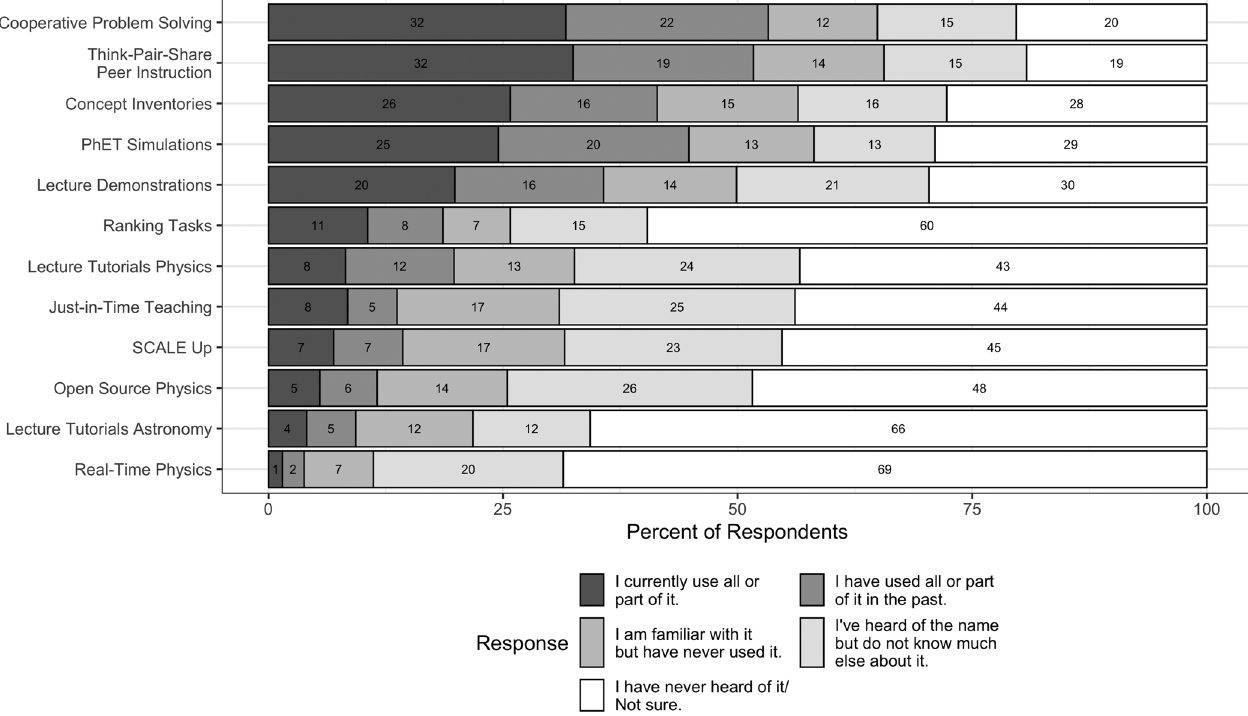
FIG. 3. Level of knowledge and use of specific EBIPs in the